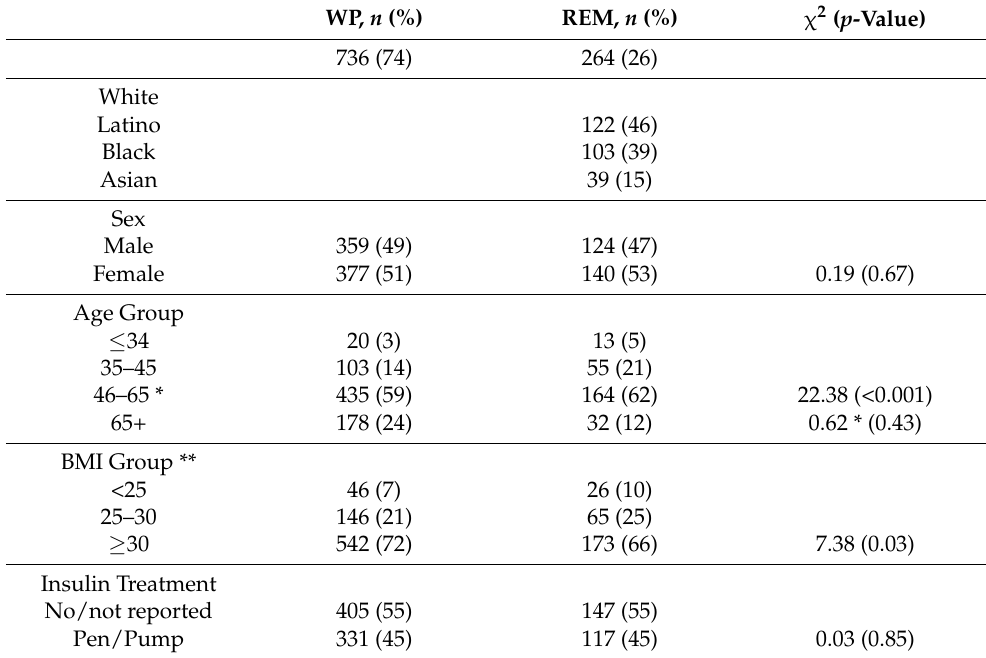
Table 1. Demographic characteristics of the users. WP, White persons; REM, people from racial and ethnic minority groups; BMI, body mass index; n , number of users; (%) percentages are rounded off and are without decimal